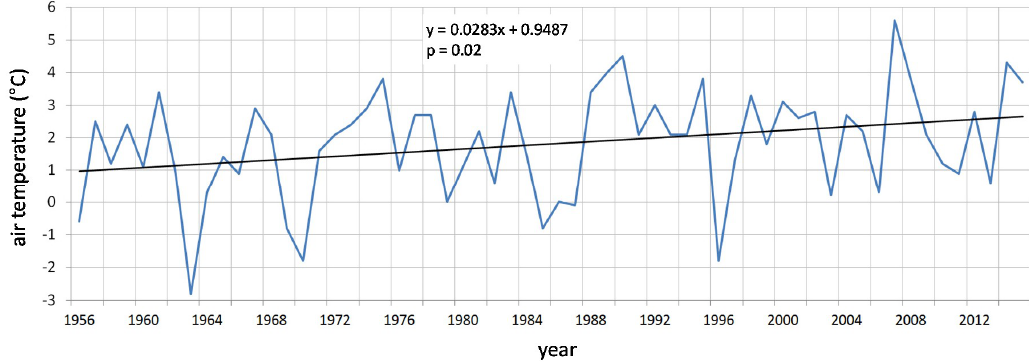
Figure 9. Mean air temperature in the months of possible occurrence of ice phenomena (November– March) in Słubice, 1956–2015 (based on data from the Institute of Meteorology and Water Management—National Research Institute in Warsaw).